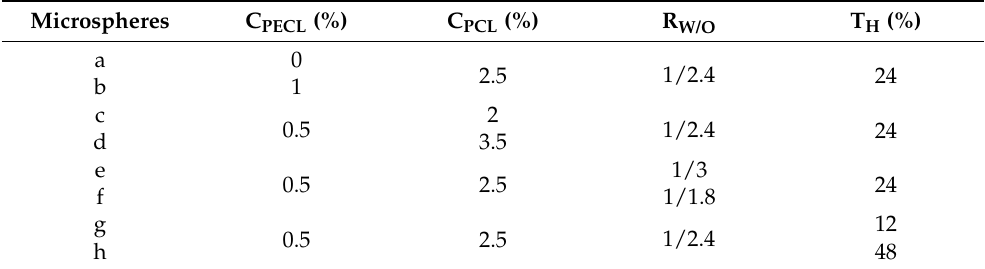
Table 1. The preparation parameters of different microspheres. C PECL (PECL concentration, w / w ), C PCL (PCL concentration, w / w ), R W/O (mass ratio of W to O), and T H (homogenization time). Microspheres C PECL (%) C PCL (%) R W/O T H